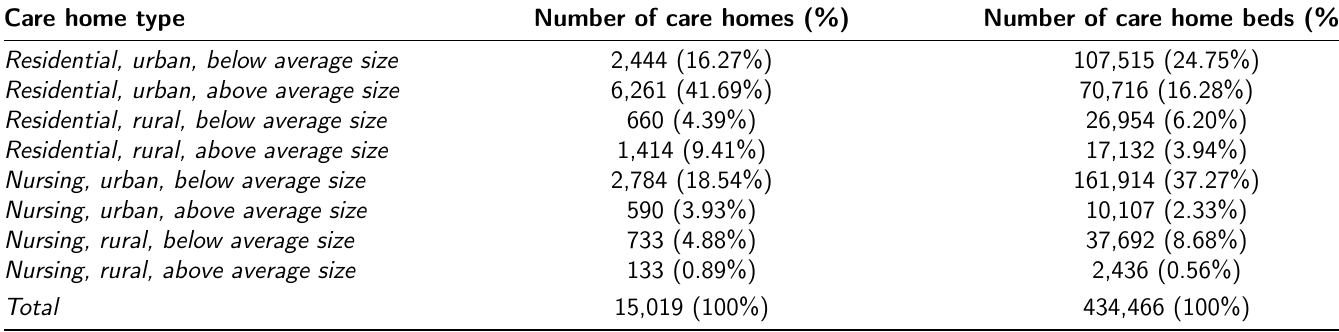
Table B: Estimates of diagnostic performance parameters for the UPRN index test vs manual address matching (base-case analysis). Proportions represent estimates derived from the adopted (stratified) sampling design; numerator/denominator figures indicate raw (non-) residents’ numbers. Individuals for whom no UPRN match could be found (shown between parenthesis) are classed as